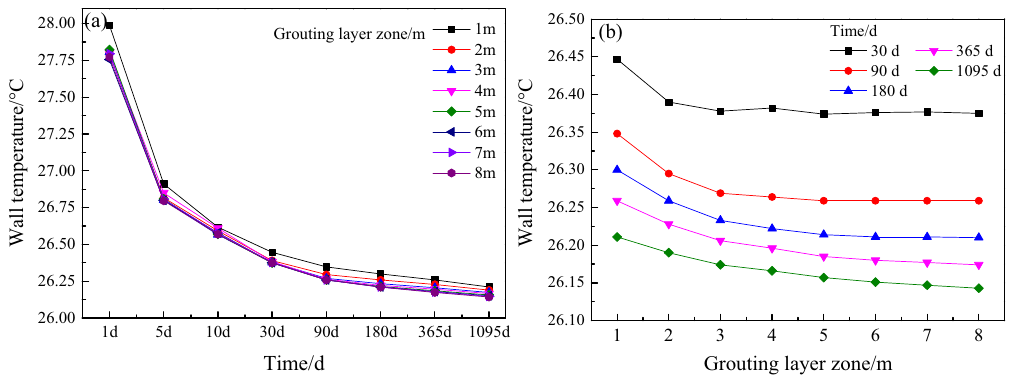
Figure 14: Influence of grouting layer zone on wall temperature: ( a ) wall temperature change with time; ( b ) wall temperature change with grouting layer zone range.